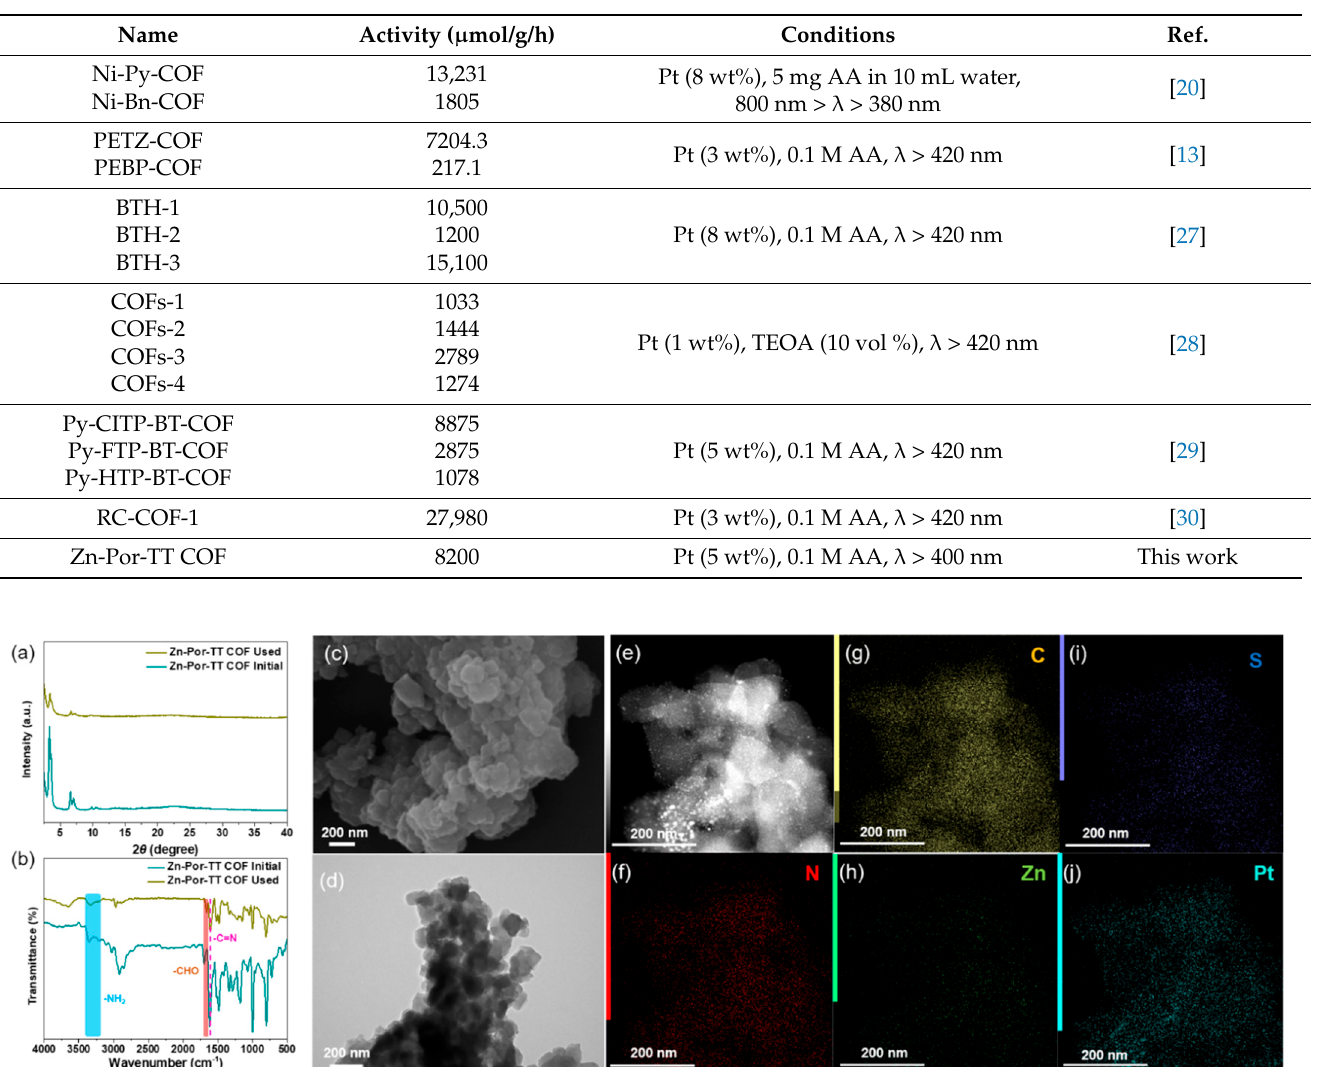
center on the photocatalytic performance, COF-366-Zn without the TT donor units and a Por-TT COF free of Zn (II) coordination center were constructed and employed to function as contrasted photocatalysts for the H 2 evolution. The chemical constitution, crystallinity, and morphology of COF-366-Zn and Por-TT COF were unequivocally characterized by